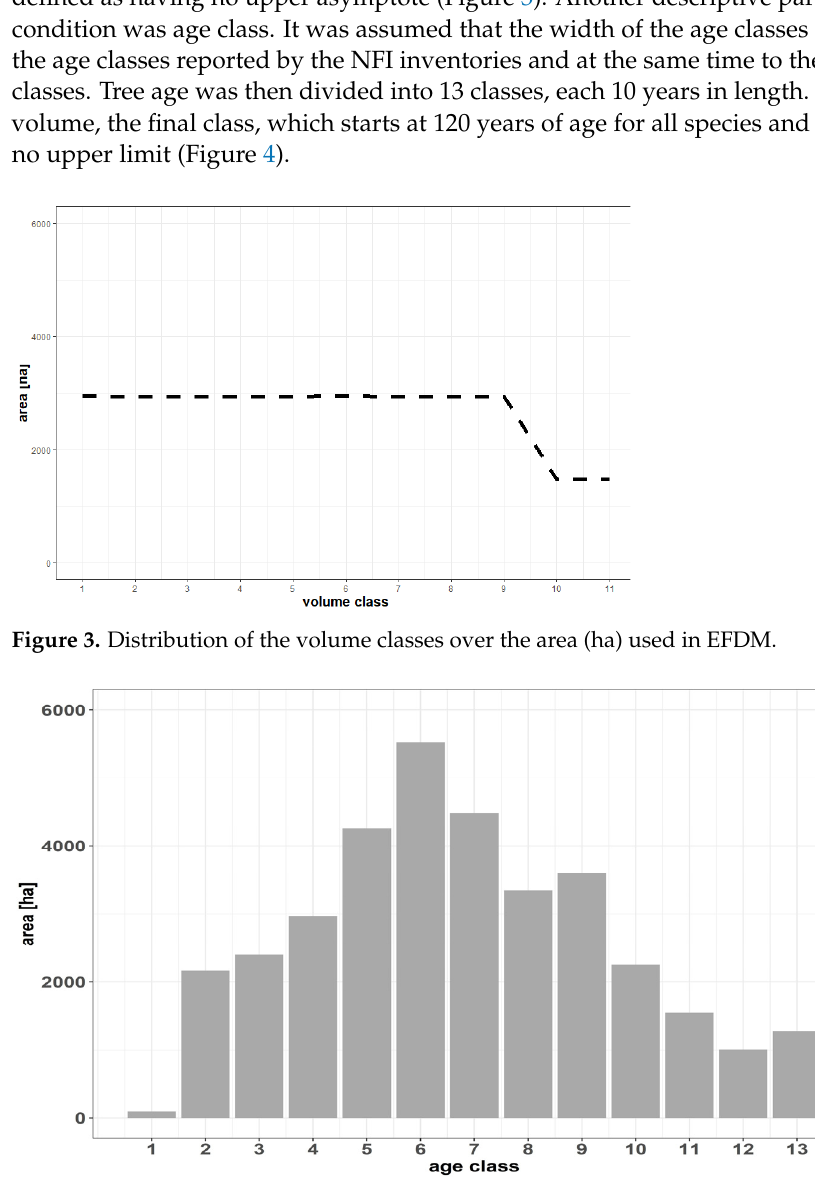
Figure 4. Distribution of age classes over the area (ha) used in EFDM.